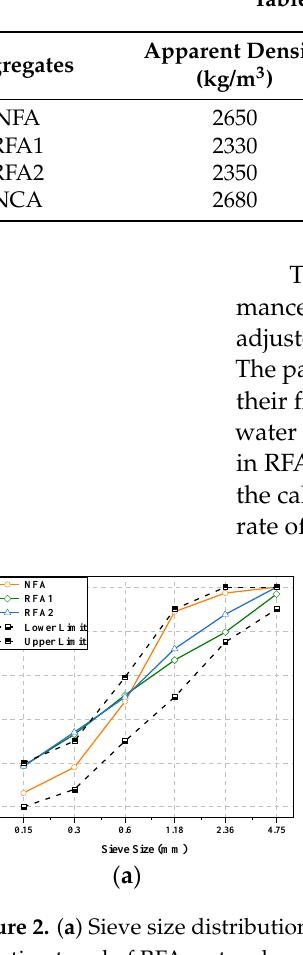
Table 3. Physical properties of natural and recycled aggregate.